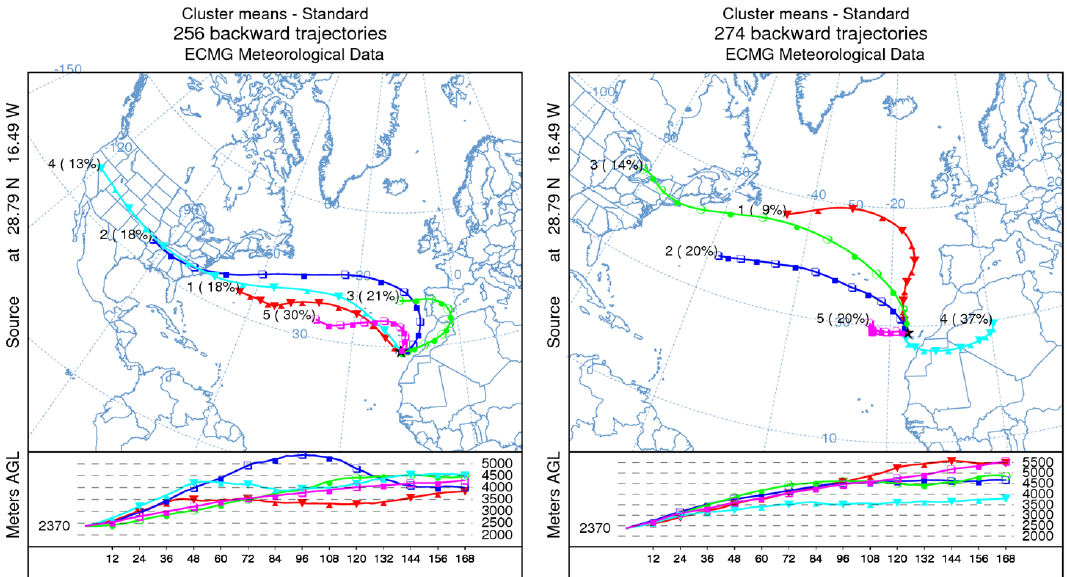
Figure 7. One-week HYSPLIT back trajectory clusters arriving at Izaña observatory for the winter months (DJF), left panel, and for the summer months (JJA), right panel, for the years